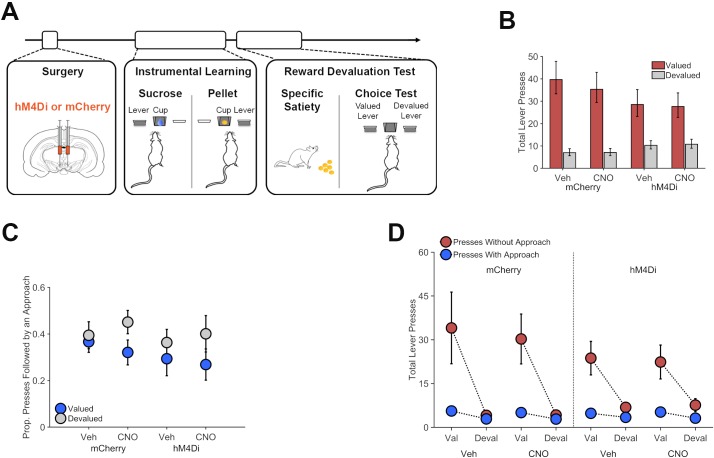
Chemogenetic inhibition of dopamine neurons on reward devaluation performance.(A) Th:Cre+ rats received VTA injections of AAV-hSyn-DIO-hM4Di-mCherry or AAV-hSyn-DIO-mCherry. Following recovery, rats were trained on two distinct lever-press actions for two different rewards (Instrumental Learning). Rats then underwent reward-specific devaluation testing following treatment with CNO (5 mg/kg) or vehicle. (B) Chemogenetic VTA dopamine inhibition did not alter the impact of reward devaluation on reward seeking. Total lever presses on the valued (red bars) and devalued (gray) levers in hM4Di or mCherry expressing Th:Cre+ rats, following CNO (5 mg/kg) or vehicle treatments. (C) Proportion of valued (blue) and devalued (gray) lever-press actions that were followed by a food-cup approach. Rats were more likely to attempt to retrieve reward after performing the devalued lever-press action. This effect was not altered by VTA dopamine neuron inhibition. (D). Lever presses performed without a subsequent food-cup approach response (red) were more sensitive to reward devaluation than presses that were followed by an approach (blue).10.7554/eLife.43551.019Figure 5—source data 1.This spreadsheet contains the behavioral responses for individual rats in Figure 5.